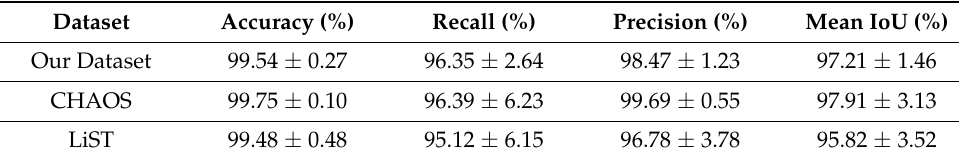
Table 3. Measurement performances of AIM-Unet on test datasets.